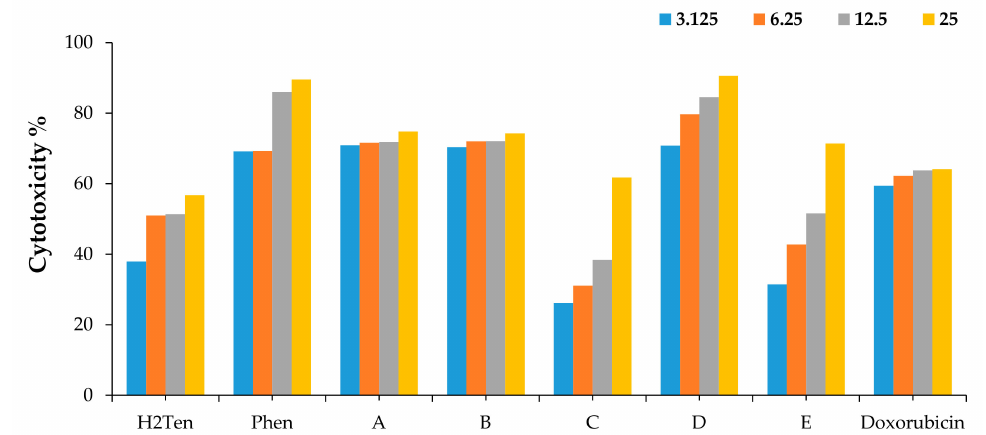
Figure 5. Dose dependent cytotoxic activities of H 2 Ten, Phen and their metal complexes against HCT-116 cancer cells according to the MTT assay. Where: 3.12, 6.25, 12.5, and 25.0 µ M are the concentrations, diluted in DMSO, used for the MTT